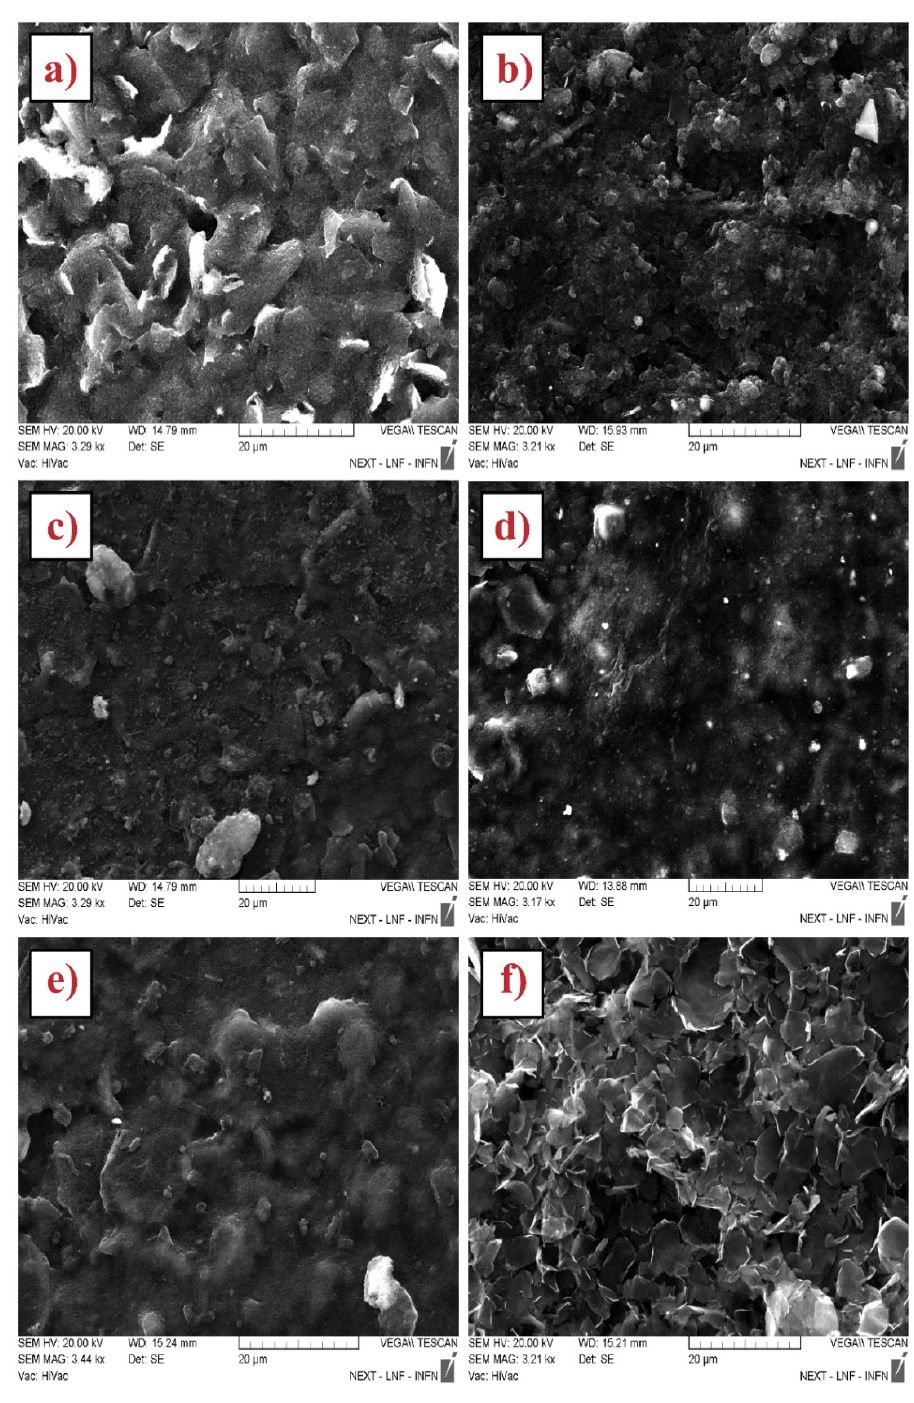
Figure 1. SEM characterization: ( a ) Bare SPE, ( b ) Bare MWNT, ( c ) CO 2 H-MWNT-SPE, ( d ) NH 2 -MWNT-SPE, ( e ) OH-MWNT, and ( f ) GNP-modified SPE.